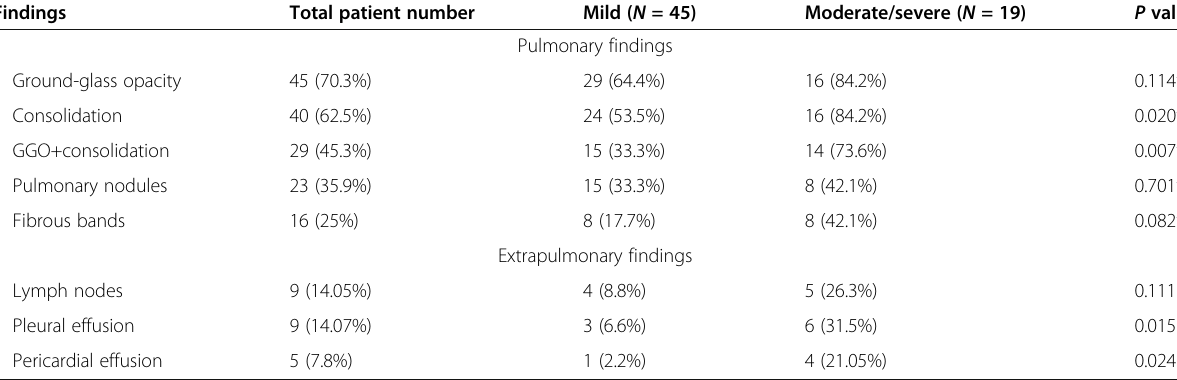
Table 2 Chest CT criteria in COVID-19 patients